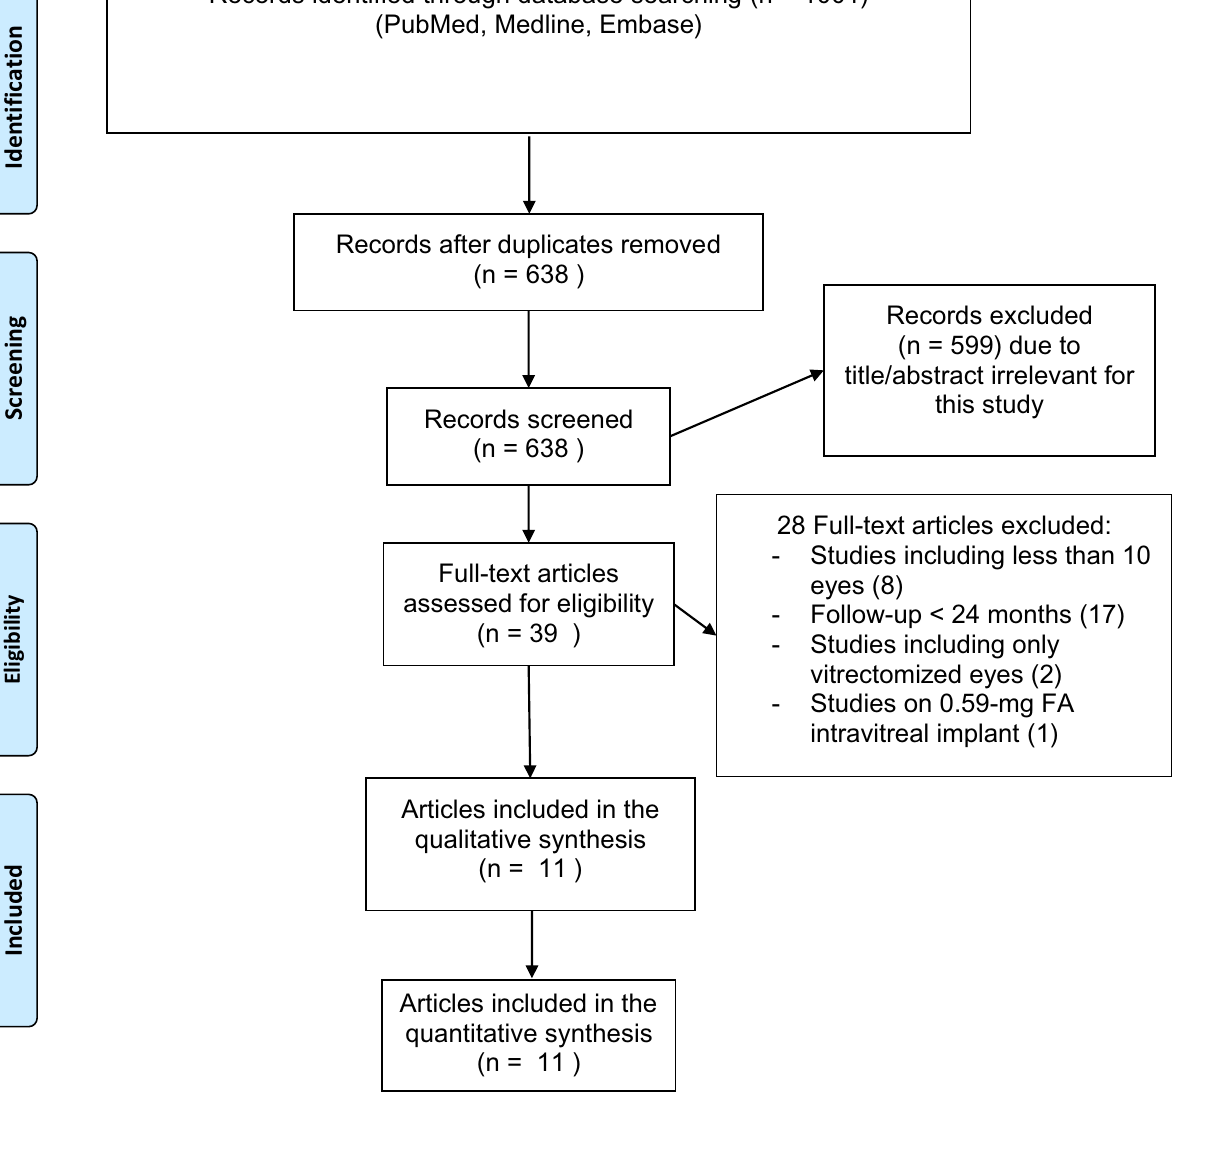
Figure 1. Flow chart of study selection